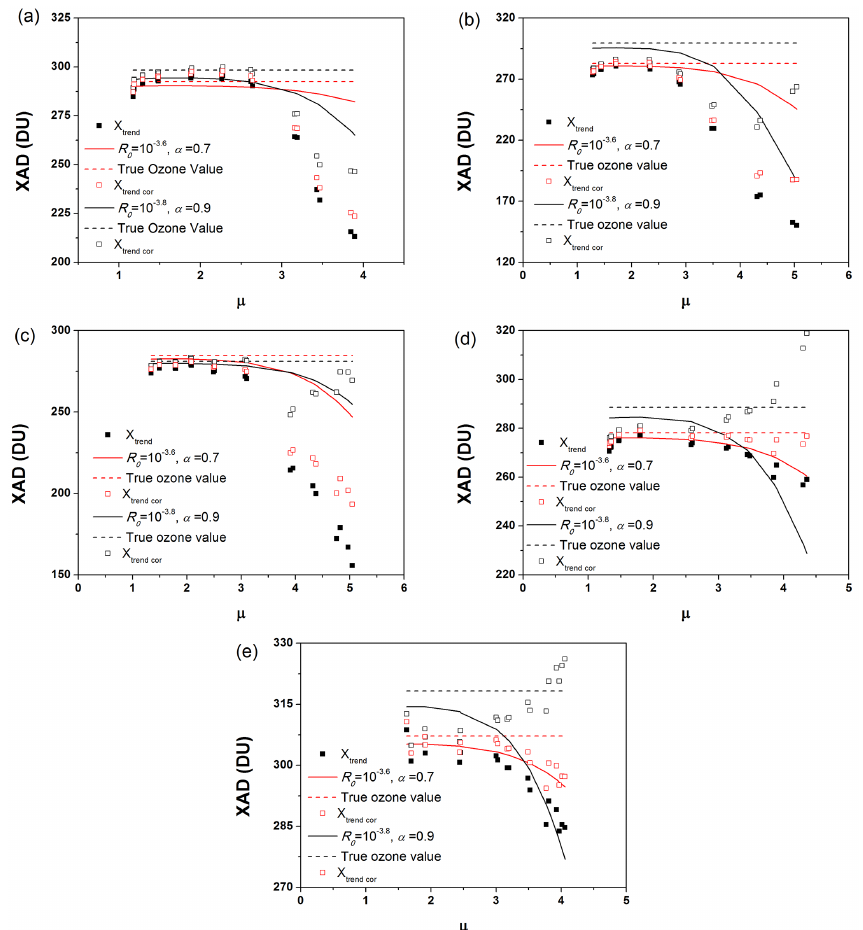
Figure 3. Comparison of experimental data (black dots) with stray light model applied for two different sets of parameters R 0 and α (solid lines) along with the corresponding true ozone values (dashed lines). Empty dots, red and black, represent the corrected measurements using the values R 0 = 10 − 3 . 6 , α = 0 . 7 and R 0 = 10 − 3 . 8 , α = 0 . 9, respectively. The presented pairs of R 0 , α and the corresponding true ozone value have been picked out by the final obtained results. (a) 5 September 2012, (b) 24 September 2012, (c) 29 September 2012, (d) 30 September 2012 and (e) 31 October 2012. Model was executed for values of air mass µ 1 = 1 . 0 and µ 2 = 2 .